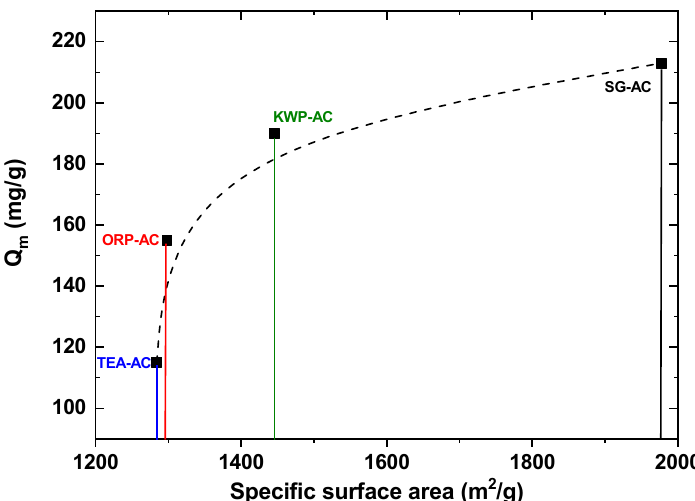
for all AC samples but with lower Q max . Table 4 shows the parameters calculated from the error analysis.